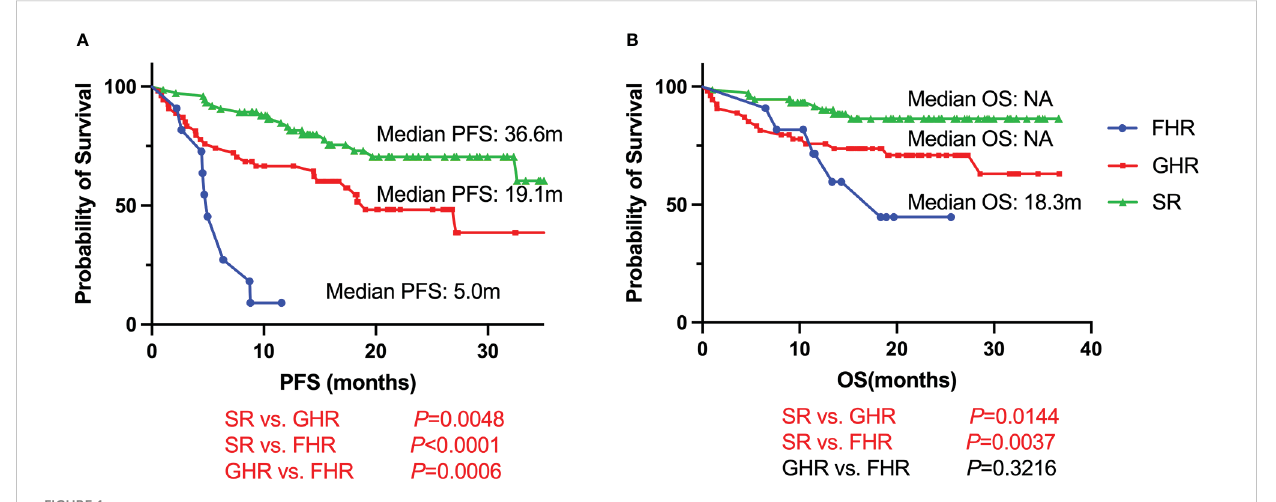
FIGURE 1 Survival curves for FHR, GHR, and SR NDMM patients. (A) PFS; (B)